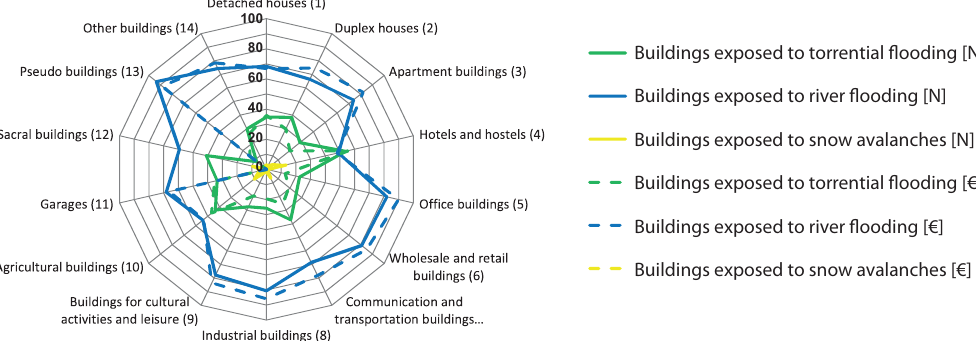
Figure 2. Radar chart of exposure (percentage of numbers and reconstruction values) to river flooding, torrential flooding and snow avalanches for different building